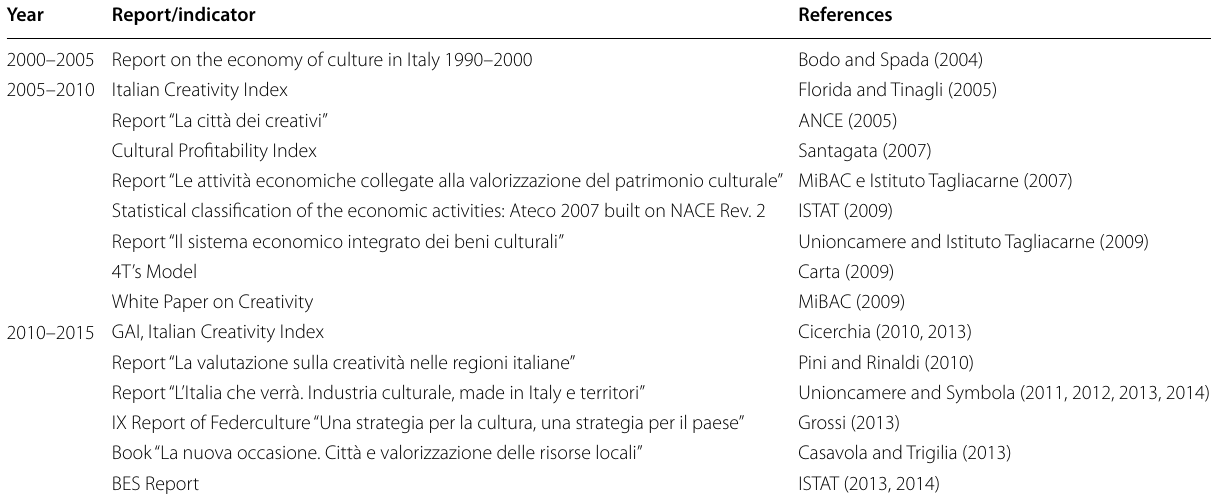
Table 3 Italian statistics on cultural and creative industries between 2000 and 2015. Source: elaboration of the